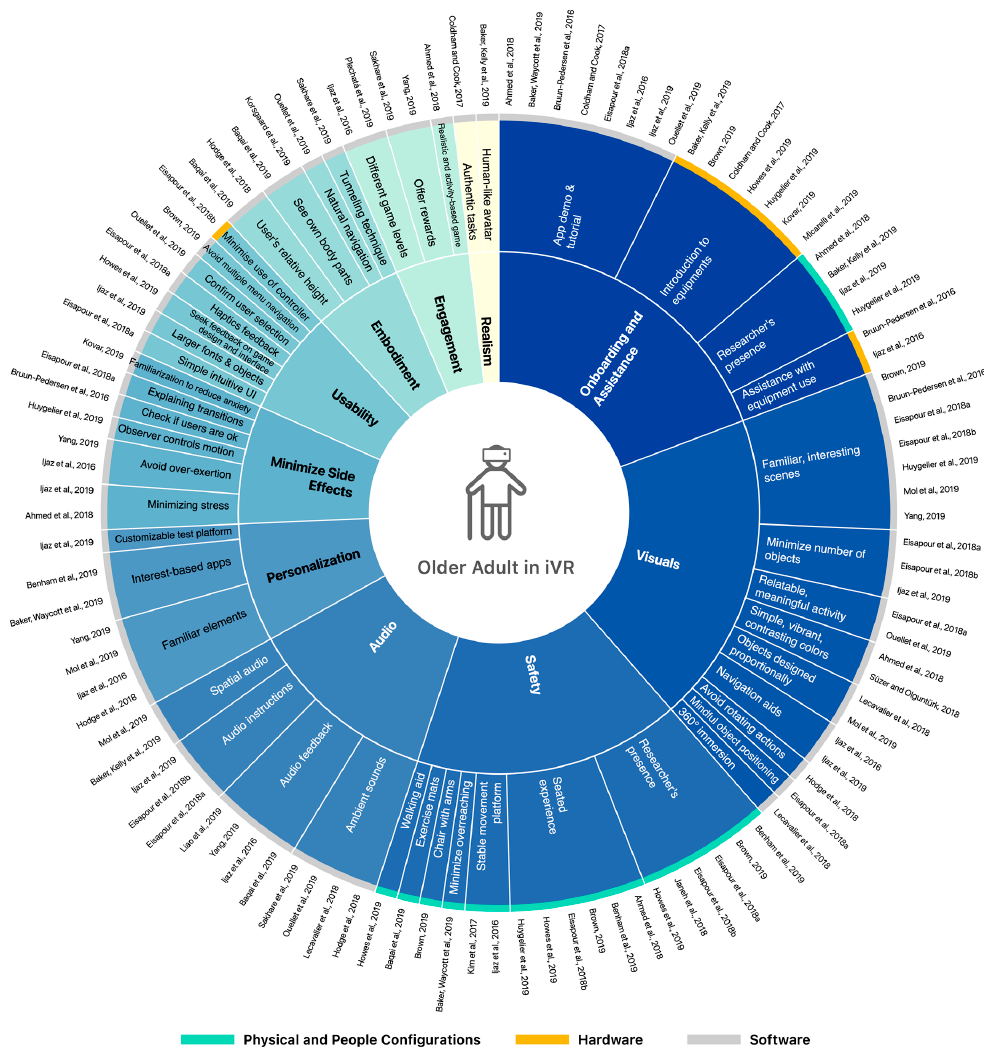
Figure 4. Design considerations grouped by themes and